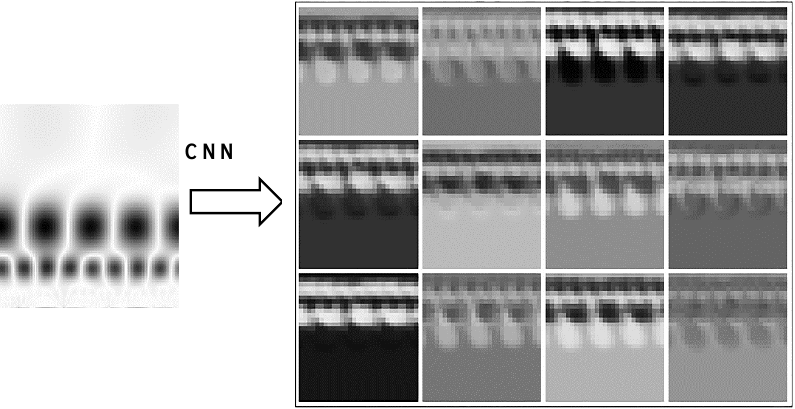
Figure 6. CNN output feature maps of a rotor misalignment fault signal CWTS, left: the CWTS of a rotor misalignment fault signal, right: twelve 29 × 29 feature maps obtained by the CNN.